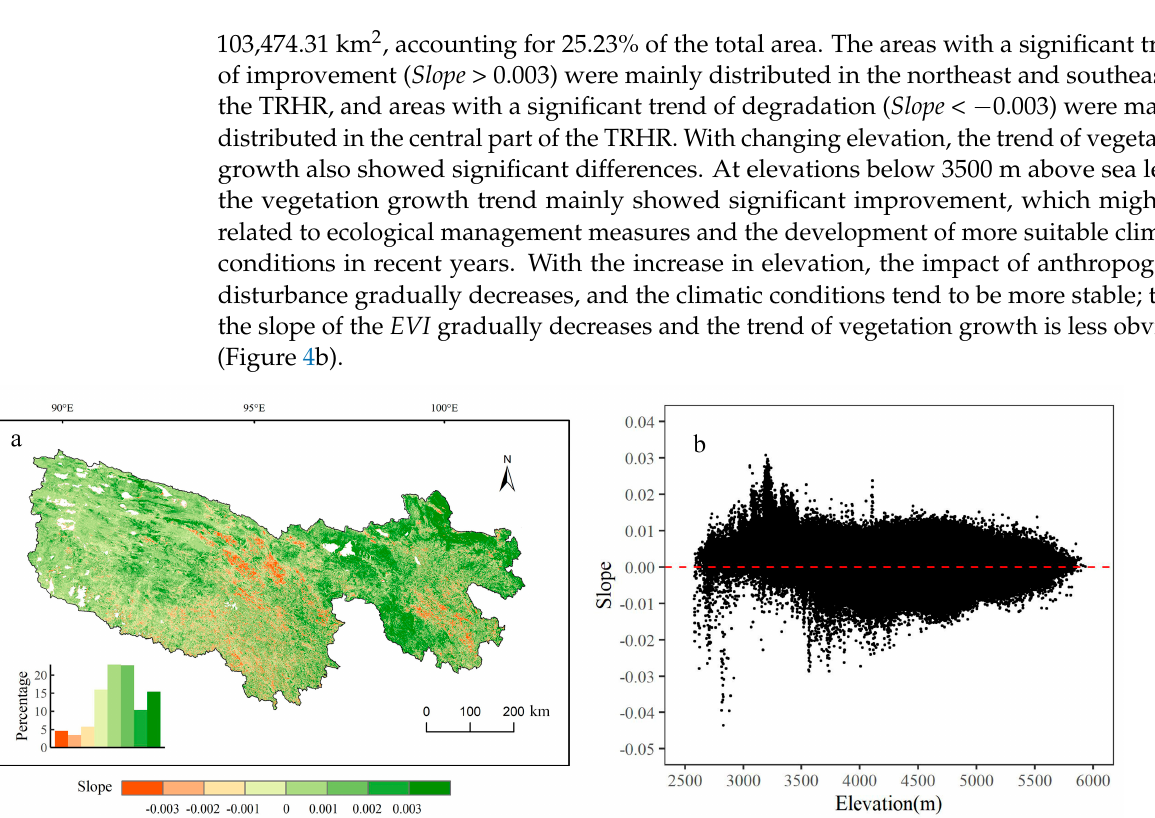
Figure 4. Distribution of the EVI linear slope ( a ) and relation between slope and elevation ( b ) in the TRHR during 2000–2021.